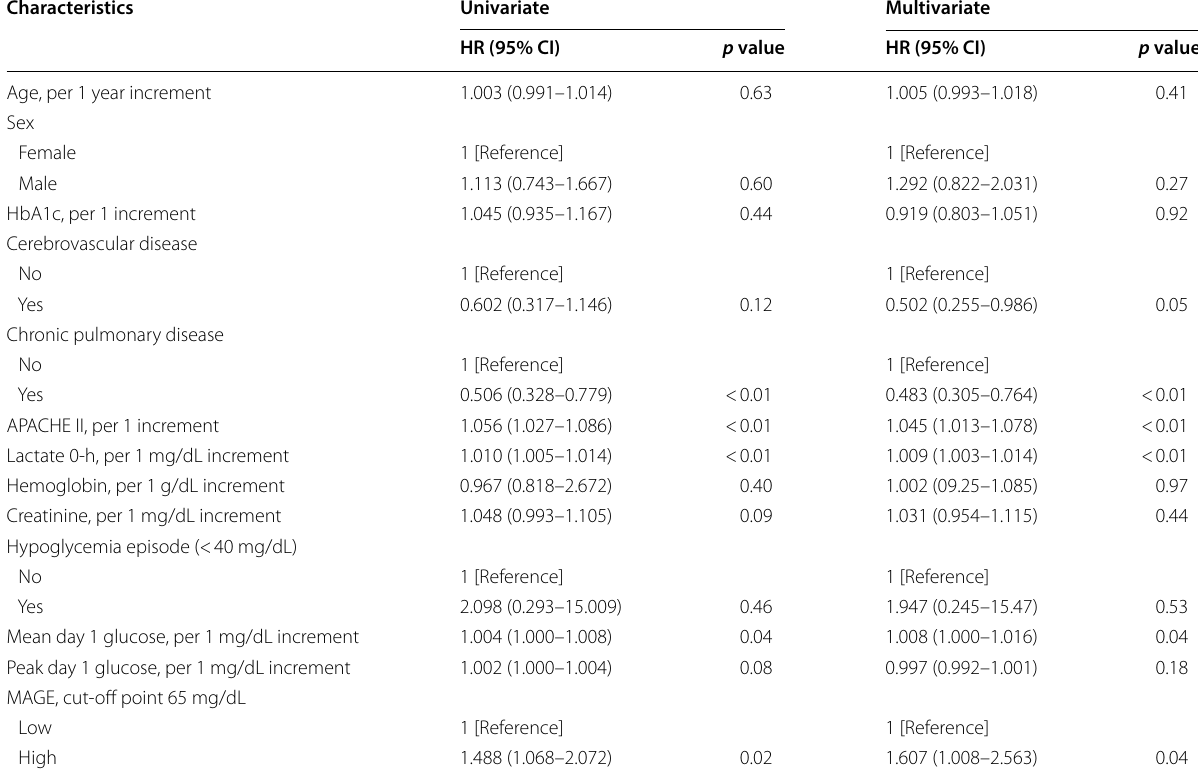
Table 2 Cox proportional hazard regression analysis for 30-day mortality Characteristics